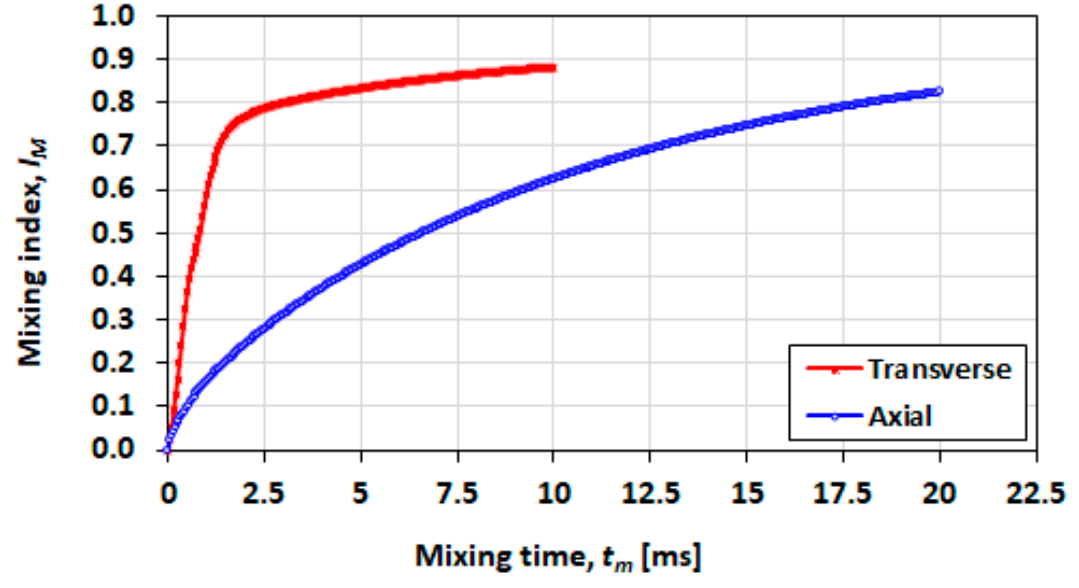
Figure 21. Effect of the initial mixing orientation on the mixing index for a droplet with initial length of L 0 = h , Ca = 0.21 and λ = 0.21.